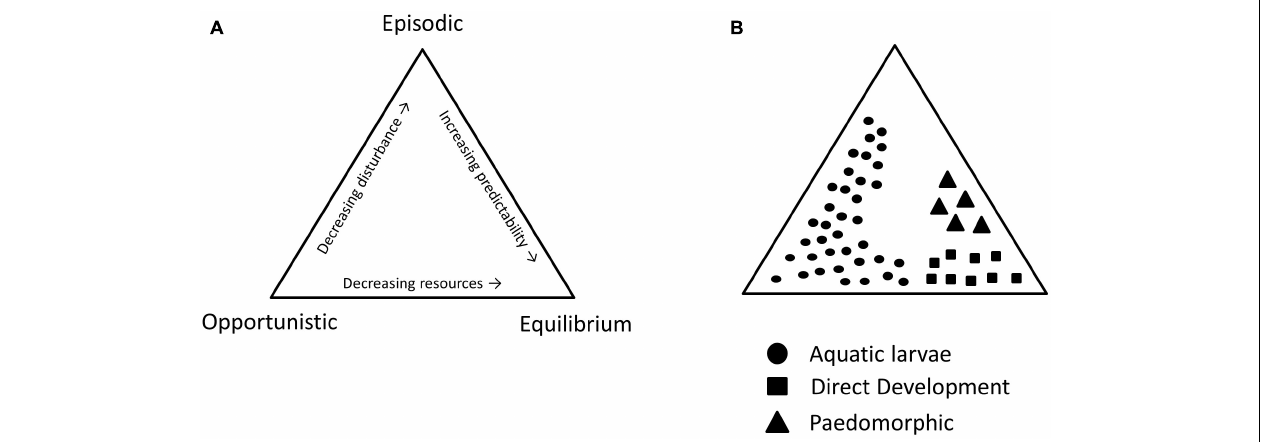
FIGURE 2 | (A) Reproduction of the life-history classification system of Winemiller and Rose (1992). A species’ position within the triangle is determined by features of the environment; selection pressures include resource abundance, disturbance regimes, and environmental predictability. (B) Assumed position of life-history strategies for amphibians with aquatic larvae (circles), direct development/viviparity (squares), and paedomorphosis (triangles), based on species age at maturity, fecundity, and juvenile survivorship. Trait data from paedomorphic and direct developing species are scant, so we have presented the hypothetical schematic here.